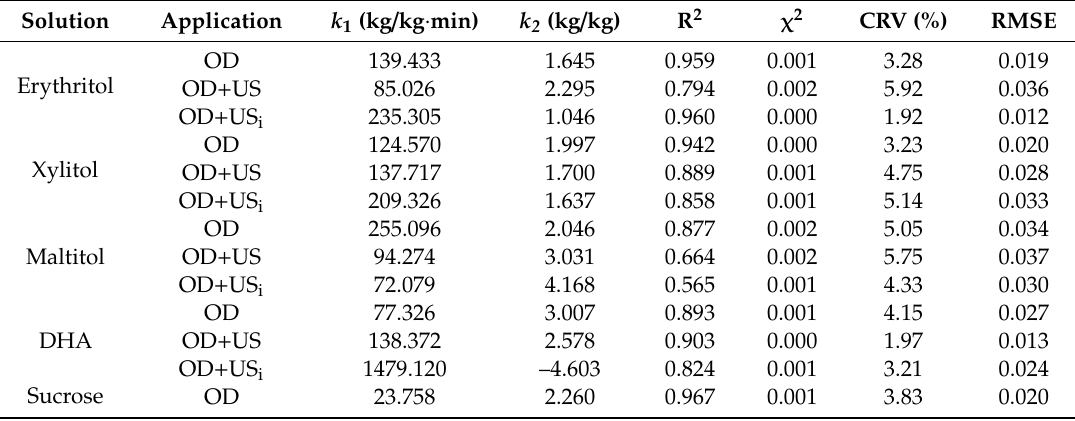
Table 10. Values of k 1 , k 2 , R2, χ 2 , CRV, and RMSE of modelling CR using Peleg’s